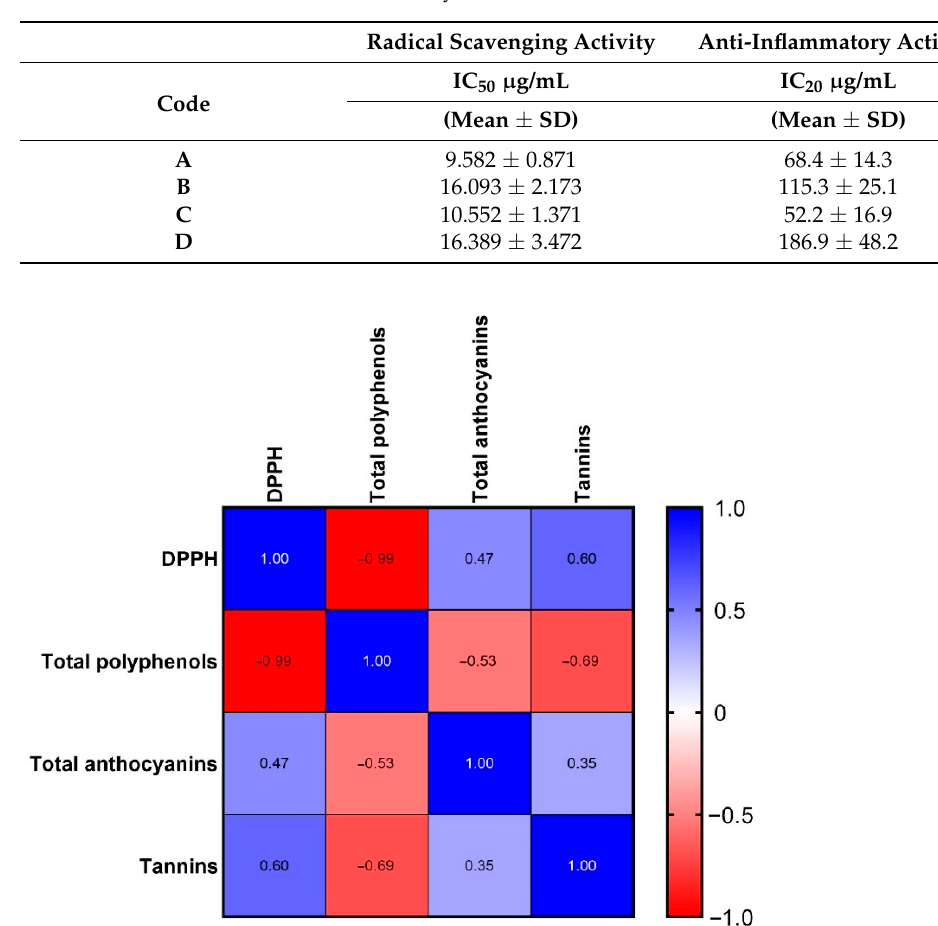
Table 4. Antioxidant and anti-inflammatory activities of enocianina.